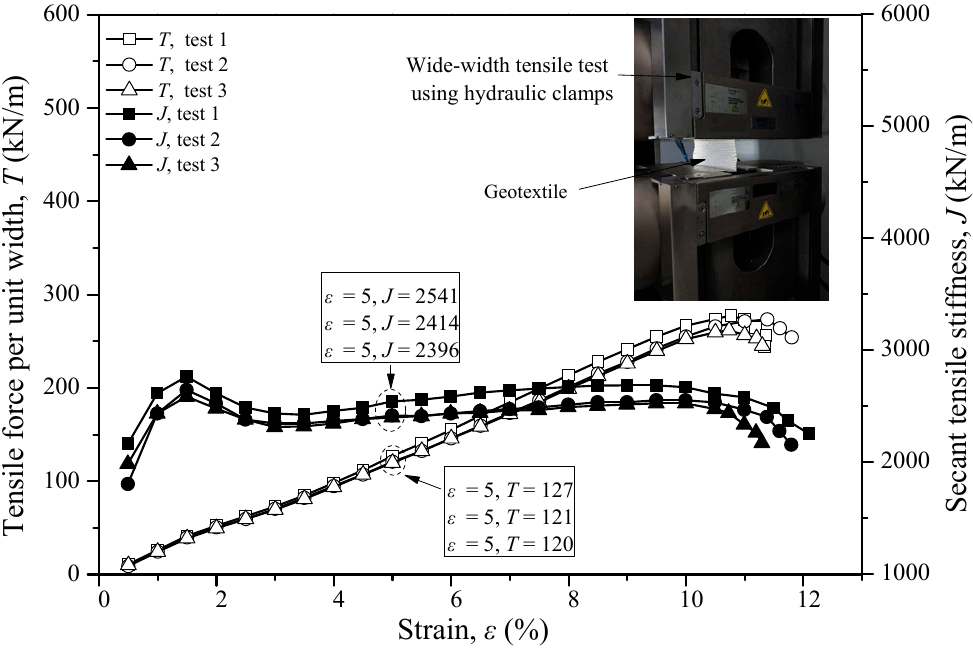
Figure 4. Load/unit width and secant tensile stiffness versus the strain curve of the geotextile. Figure 4. Load / unit width and secant tensile sti ff ness versus the strain curve of the